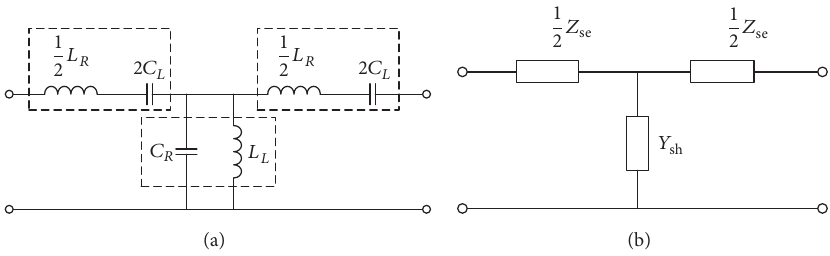
Figure 3: Equivalent circuit models of CRLH TL for parameters extraction. (a) T-type unit cell circuit model. (b) Equivalent